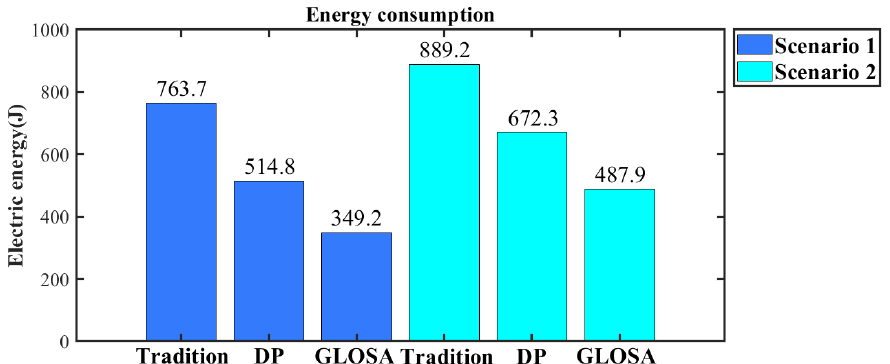
Figure 11. Energy consumption for different scenarios and